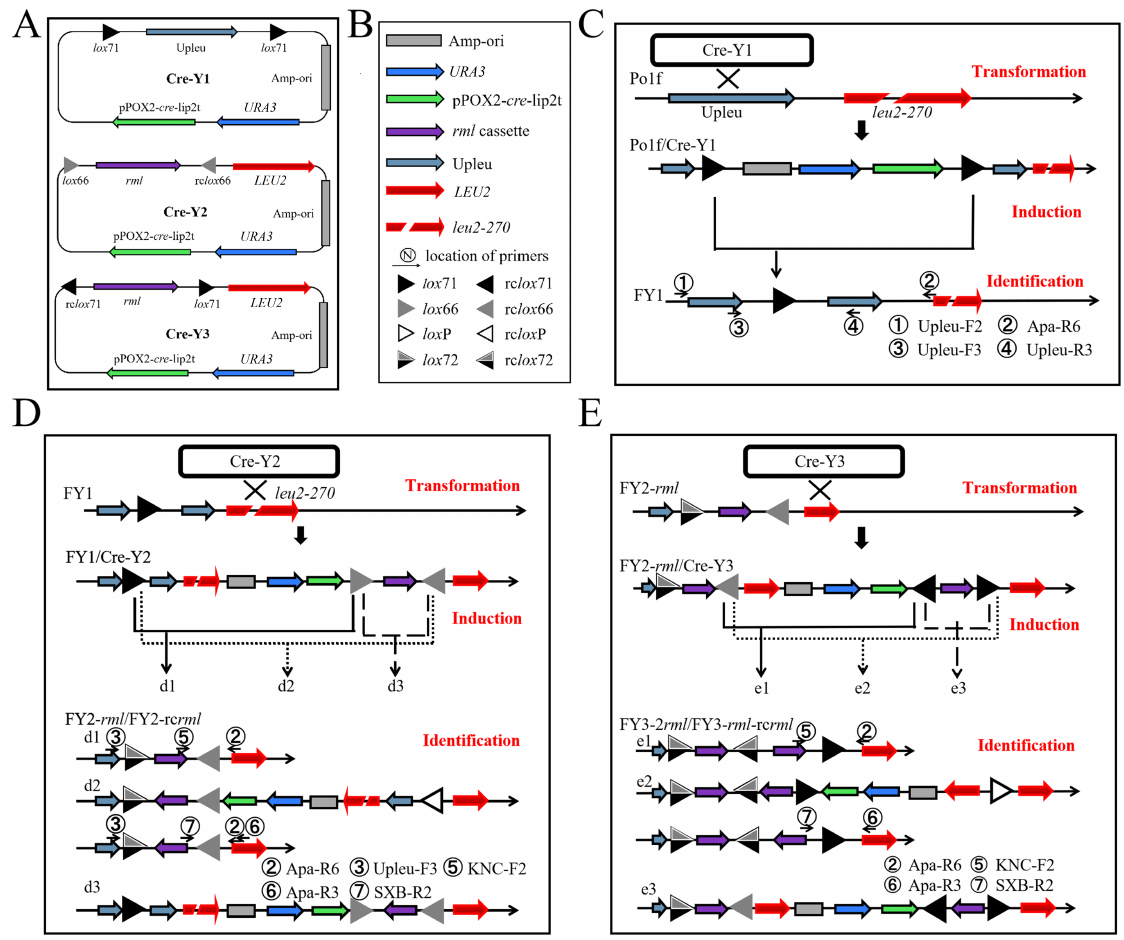
Figure 1. ( A ) Plasmid design of the novel genetic tool. ( B ) The legend of Figure 1. ( C ) Schematic diagram of first-round integration to obtain the FY1 strain. ( D ) Schematic diagram of second-round integration to generate the FY2- rml /FY2-rc rml strain. ( E ) Schematic diagram of third-round integration to construct the FY3-2 rml /FY3- rml -rcr ml strain. Primers used for PCR amplification are labeled in the figure and described in Table